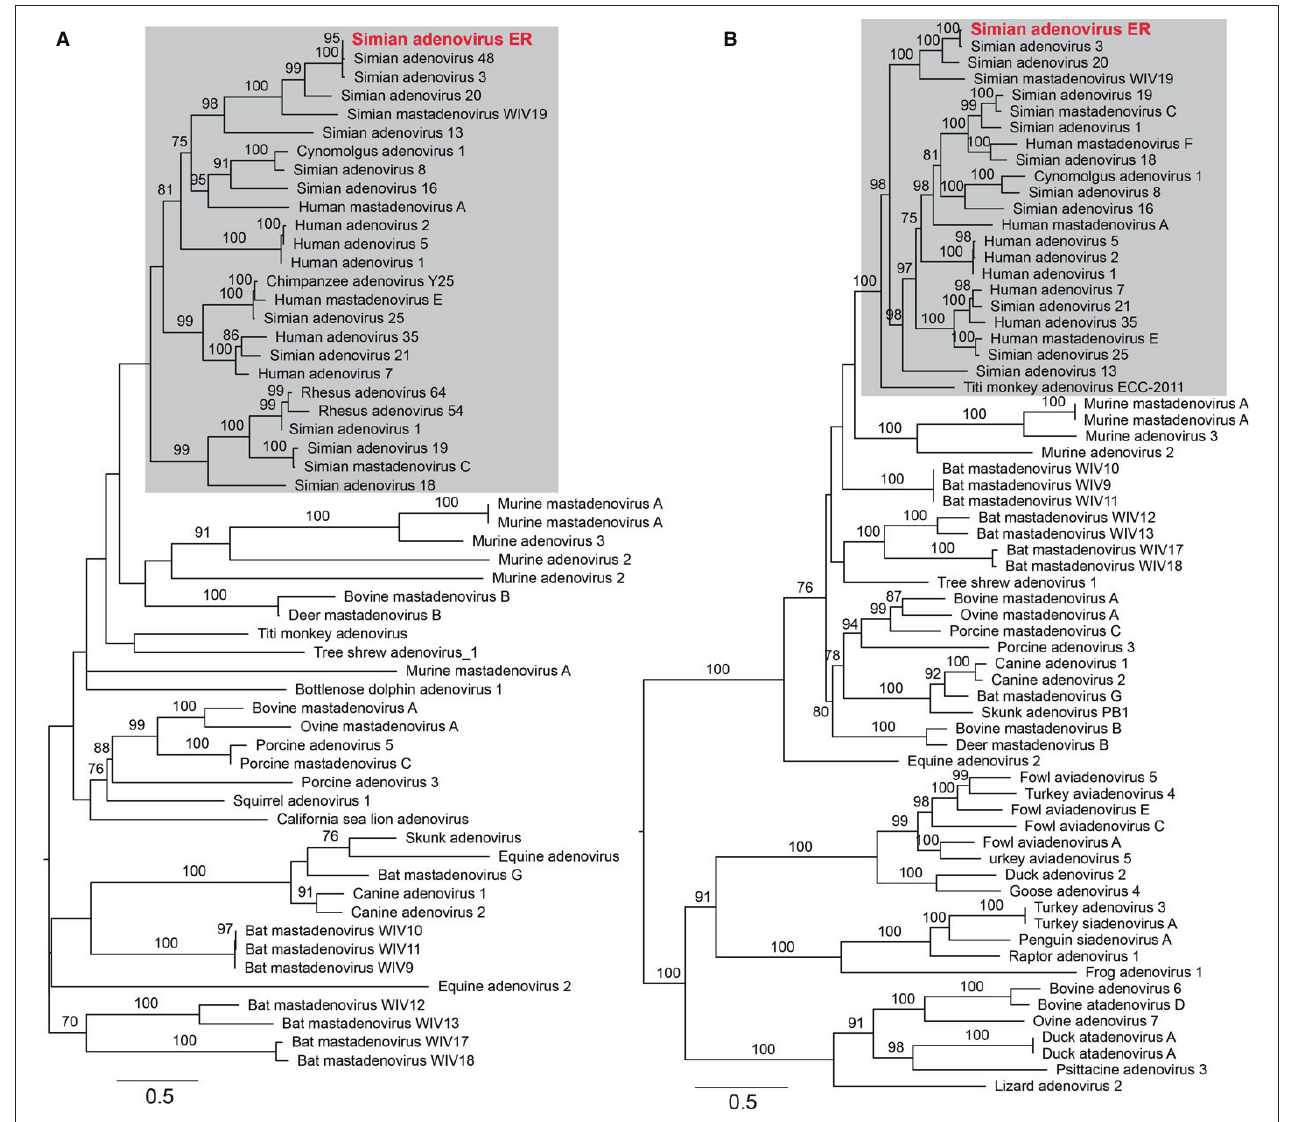
FIGURE 5 | Characterization of the newly identified simian adenovirus ER in zoo-captive monkeys. Phylogenetic analysis was performed based on the amino acid sequence of E1A (A) and 100K protein (B) . The gray shading indicates the primate adenoviruses. Branch lengths are scaled according to the number of amino acid substitutions per site. The trees were mid-point rooted for clarity